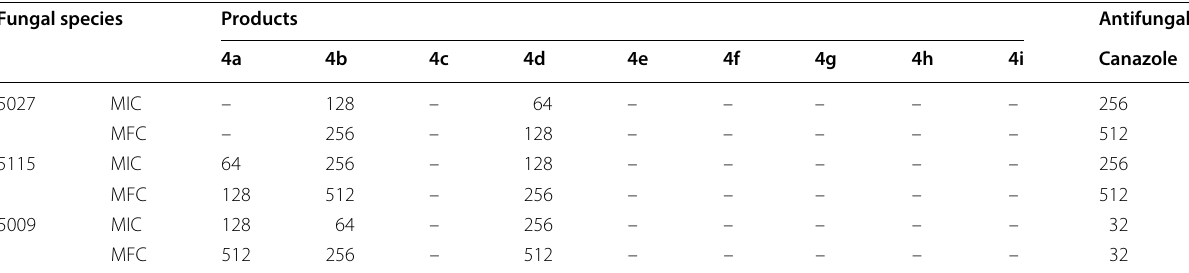
–: No noticeable antifungal effect at concentration of 10,240 μg ml − 1 , MIC (μg ml − 1 ), MFC (μg ml − 1 )